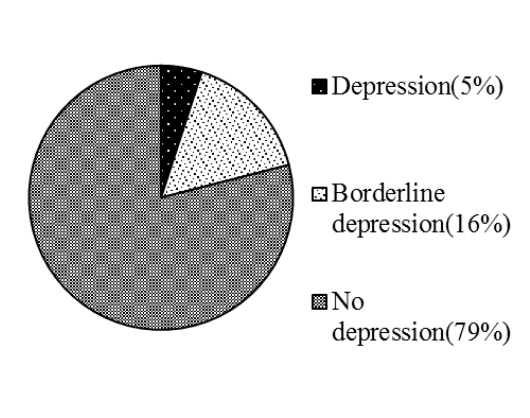
Figure 02. The distribution of depression among the study sample.